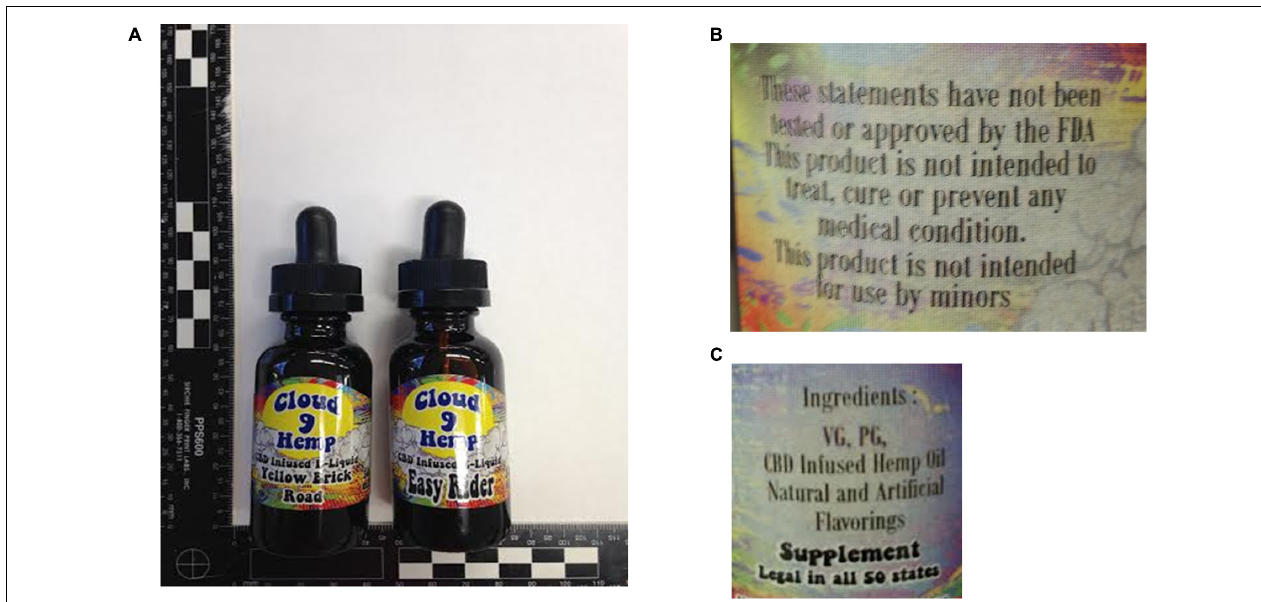
FIGURE 1 | (A) Easy Rider and Yellow Brick Road CBD e-liquids with (B) the FDA statement regarding the uses of the e-liquid, and (C) the listed ingredients of the